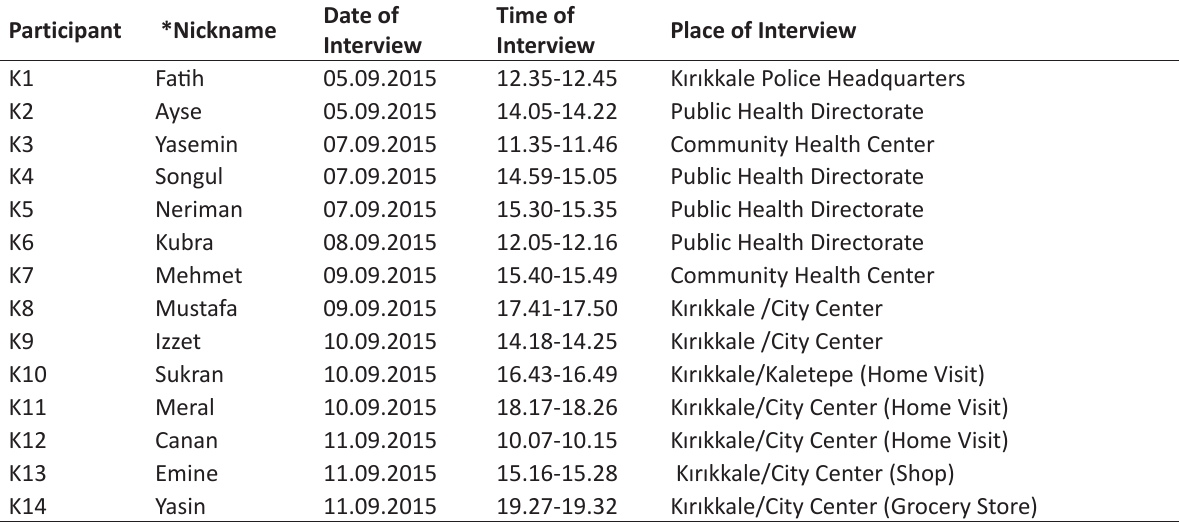
Table 2 . Information on time and place of interview Participant